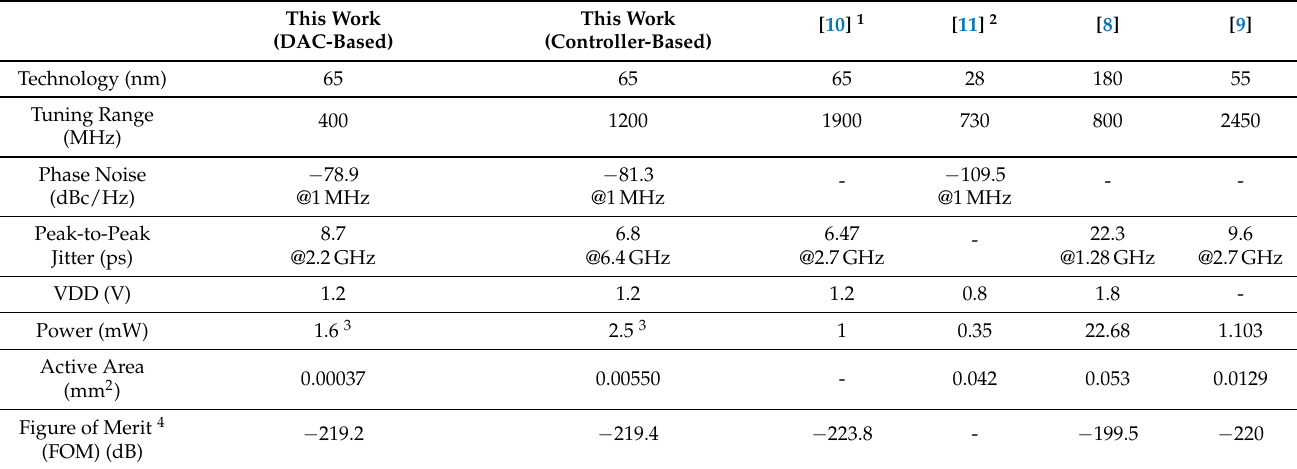
Table 1. Performance Summary and comparison with